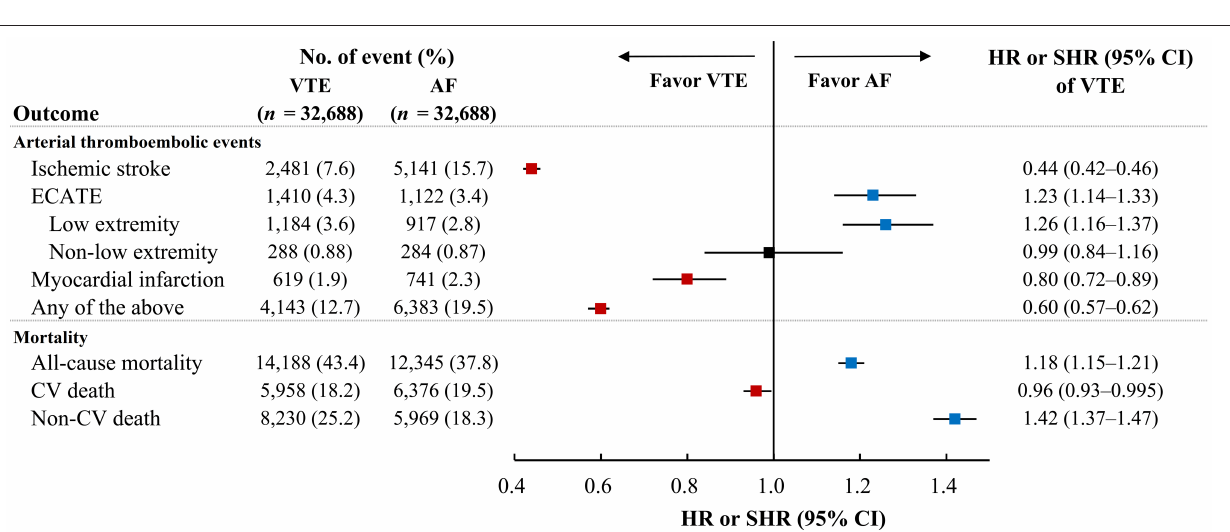
FIGURE 3 | The cumulative incidence rate of arterial thromboembolic event (A) , ischemic stroke (B) , extracranial arterial thromboembolic events (C) , cardiovascular death (D) and all-cause mortality (E) after propensity score matching between patients with pulmonary embolism (PE) alone and patients with deep vein thrombosis (DVT) alone.